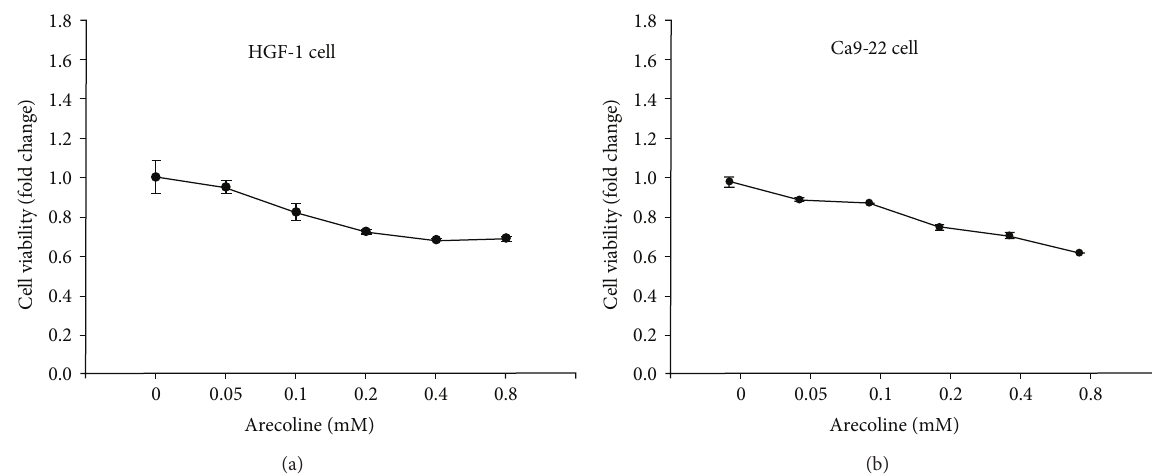
Figure 1: Effect of arecoline on the viability of HGF-1 and Ca9-22 cells. Different concentrations of arecoline were incubated with HGF and Ca9-22 cells for 24h. Cellviability was determined usingan MTTassay. (a)Arecoline induced cell death in variousconcentrations of arecoline in HGFs. (b) Arecoline induced cell death in various concentrations of arecoline in Ca9-22